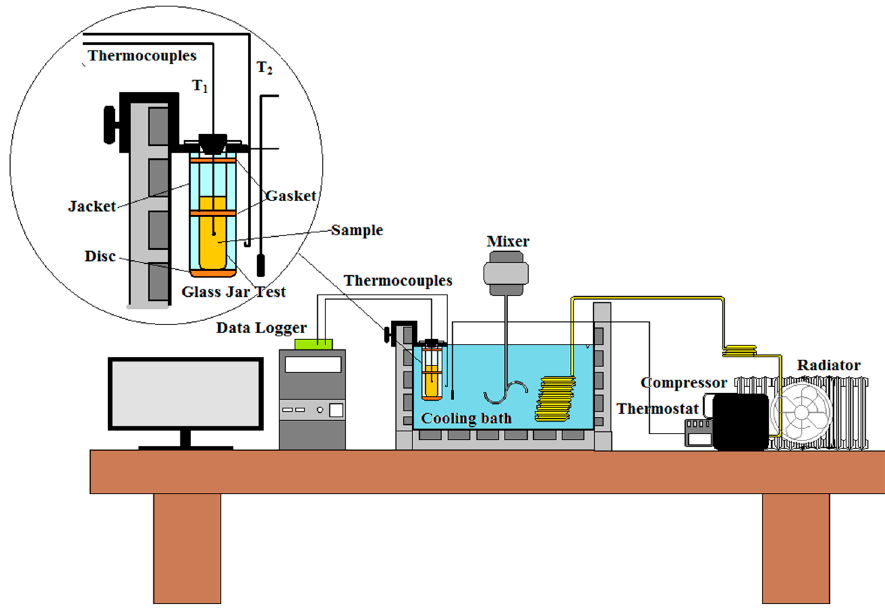
Figure 3. Experimental setup for computer-aided cooling curve analysis (CA-CCA)